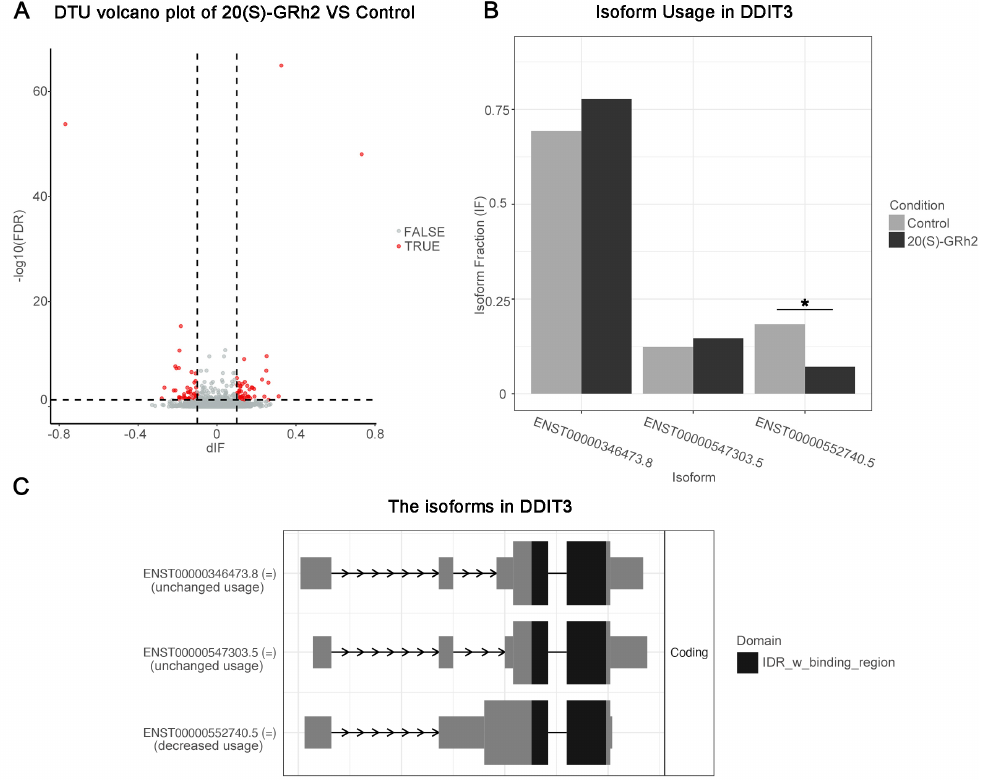
Figure 9. DTU analysis. ( A ) Volcano plots showing genes with DTU (red dots mark DTU; dif- ferential isoform fraction (dIF) > 0.05 and FDR < 0.05) in the control and G-Rh2-treated groups. ( B ) Quantitation of the isoform fraction in control and 20(S)-GRh2 treated groups. ( C ) Isoform land- scape of all 3 isoforms of DDIT3 in 20(S)-GRh2 treatment group compared with control. * p < 0.05. 20(S)-GRh2, 20(S)-ginsenoside Rh2.